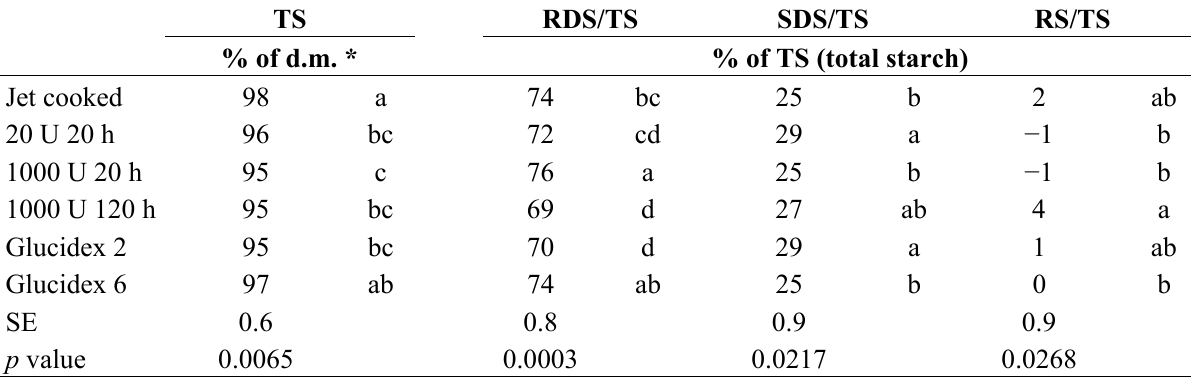
Table 2. The effect of branching enzyme at different dosages and incubation of time on in vitro starch digestion rate of waxy maize starch. TS % of d.m. *